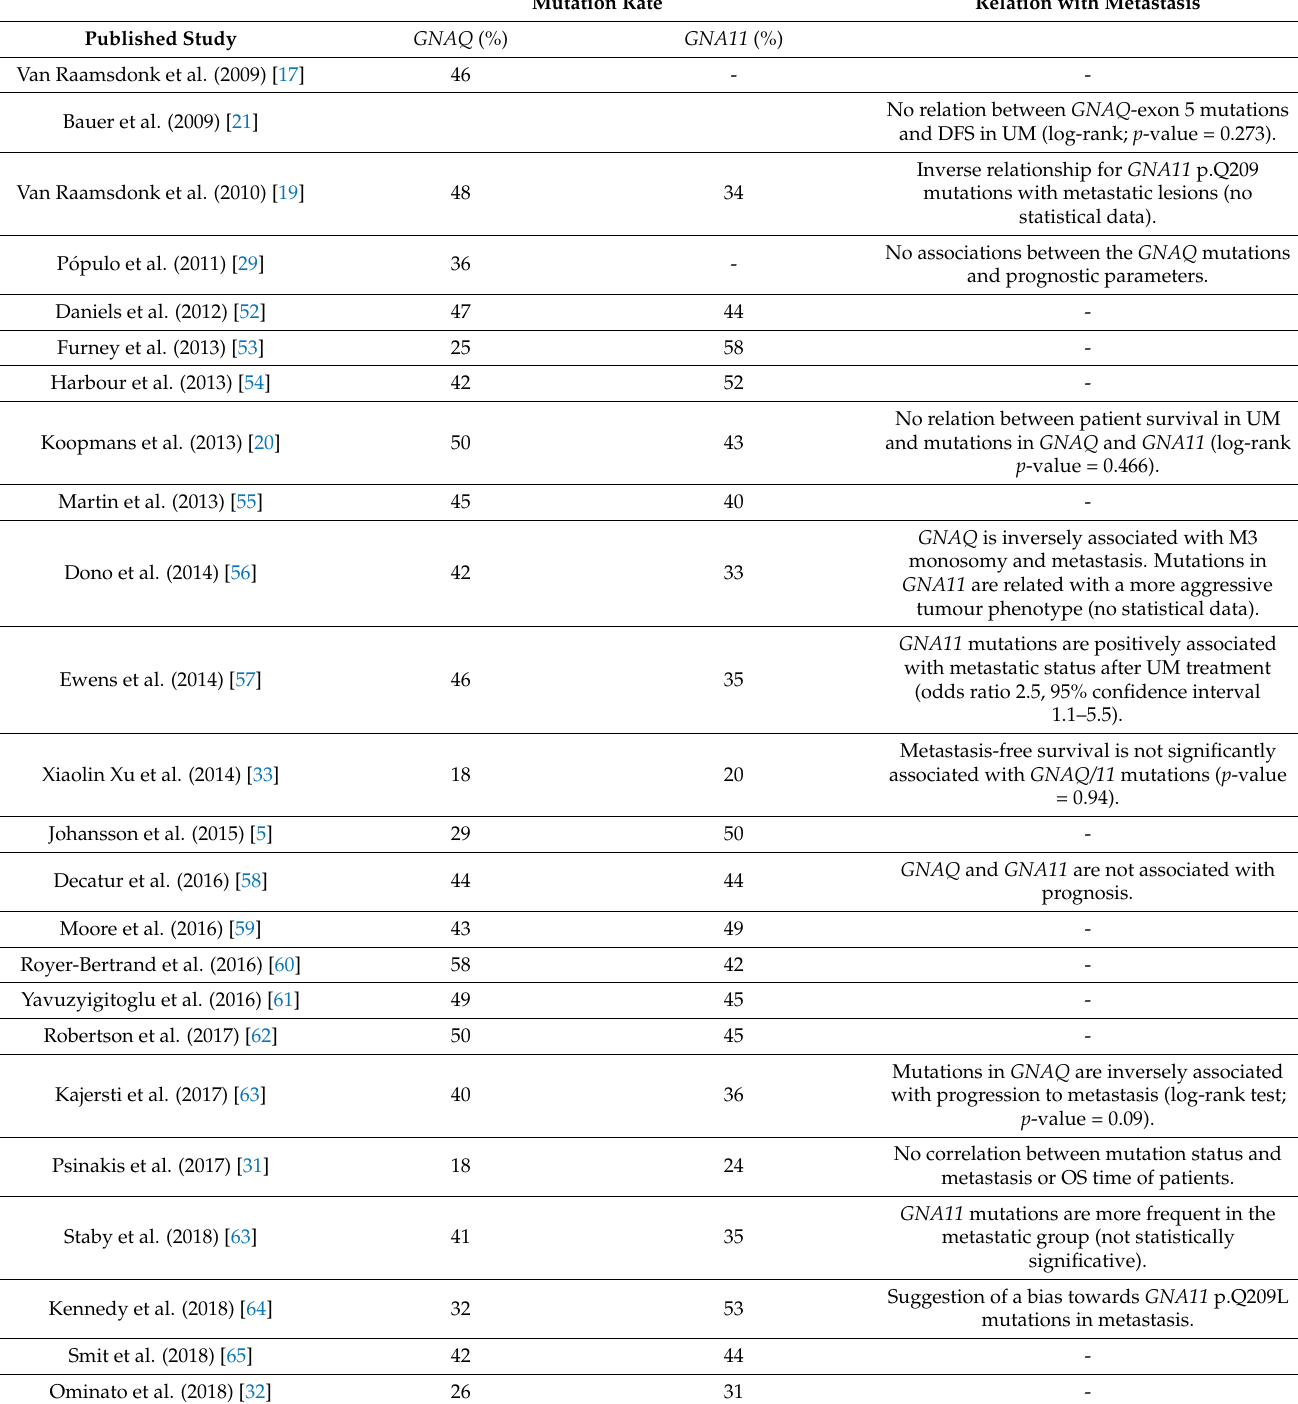
Table 2. Review of the mutation ratio of GNAQ and GNA11 genes in the current published UM sequencing studies and the putative prognostic implication of those genes in the